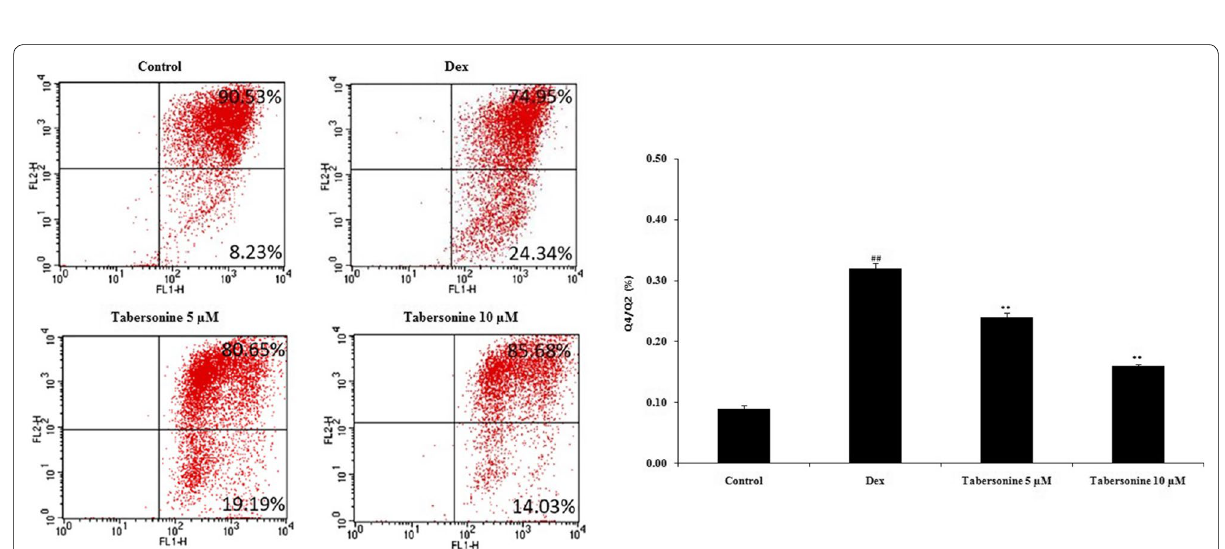
Fig. 4 Effect of tabersonine on the mitochondrial membrane potential of osteoblasts treated with dexamethasone. Means ( n 10). ## p < 0.01 vs. control, ** p < 0.01 vs. Dex =